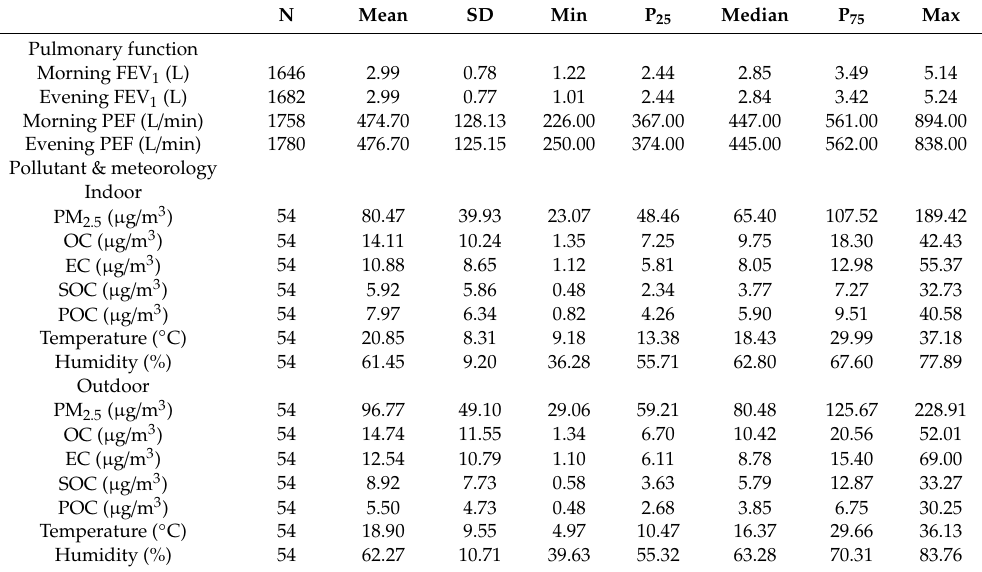
Table 2. Descriptions of pulmonary function, pollutants, and meteorological variables. N Mean SD Min Median Pulmonary function Morning FEV 1 (L)